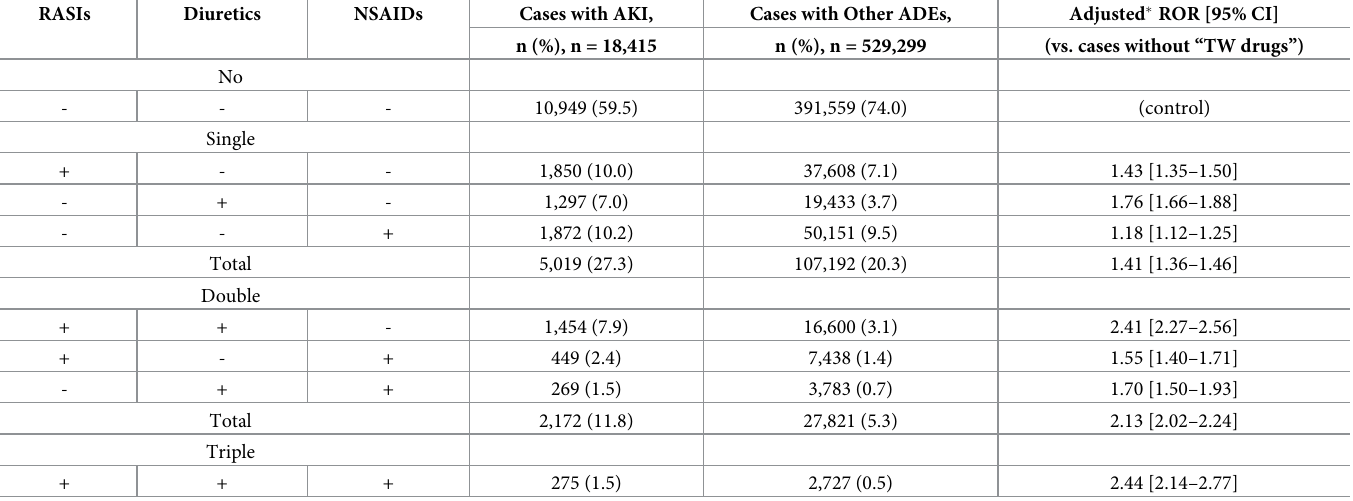
Table 1. Comparison of TW drug combination in cases with AKI and other